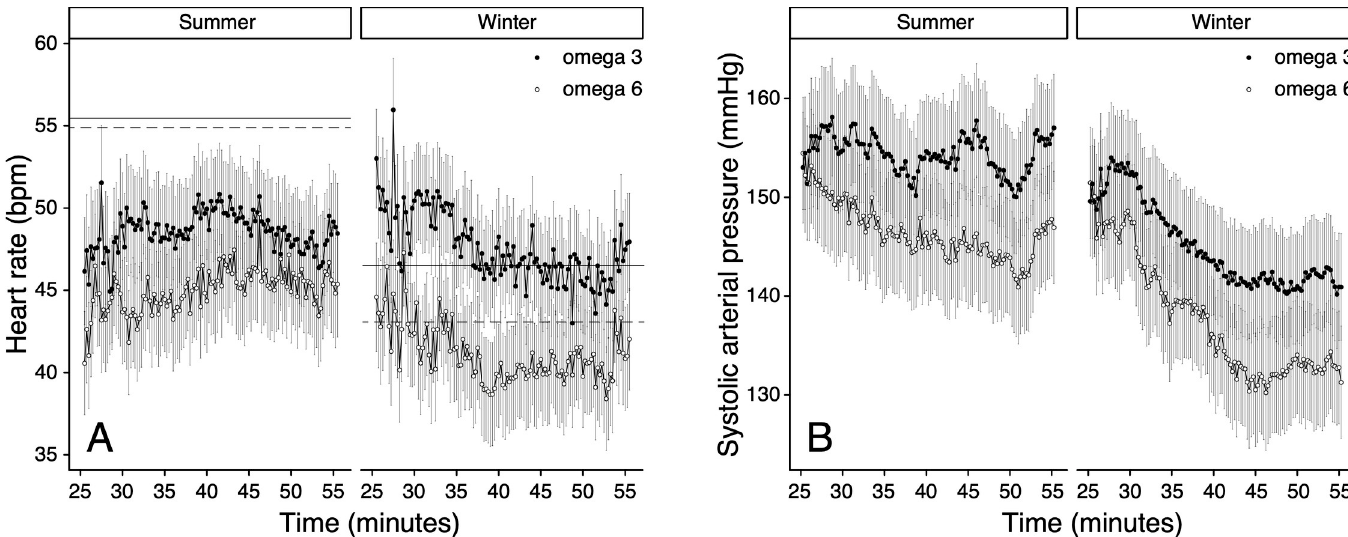
Fig 3. Seasonal differences during periods of unrestricted ( ad libitum ) and restricted food intake on heart rate (A) and direct systolic arterial pressure (B) in female red deer ( Cervus elaphus , n = 11). Heart rate and SAP were measured from minute 25 to 55 after anaesthesia induction (means ± standard error of the mean). Baseline heart rate values for periods of unrestricted ( ad libitum ) (solid) or restricted (dashed) pellet intake are represented by a horizontal line. (See legend Fig 2. for medetomidine- tiletamine-zolazepam